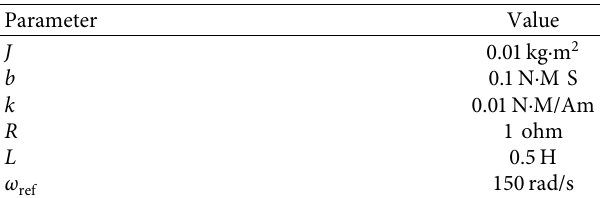
Table 9: Parameters for obtaining K and simulation for τ � 1s , 5s and stochastic disturbance.